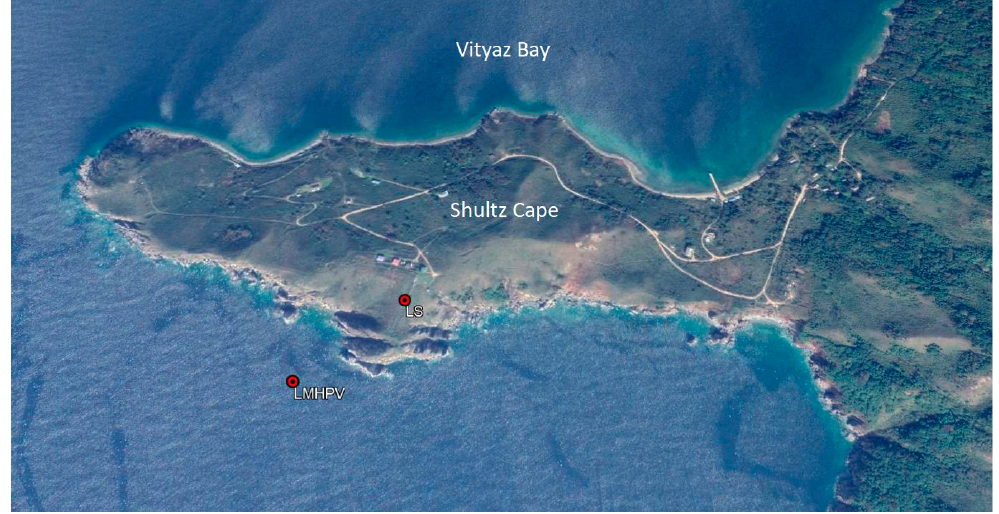
Figure 12. Map of locations of the laser meter of hydrosphere pressure variations (LMHPVs) and the laser strainmeter (LS).